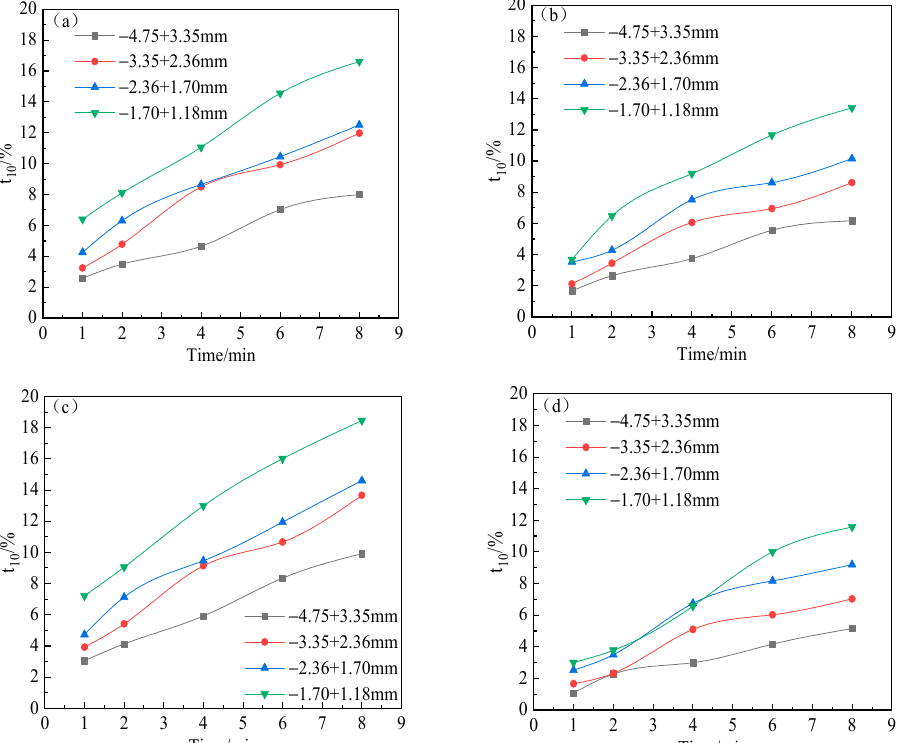
Figure 7. The relationship between grinding products t 10 and grinding time at different feed sizes.